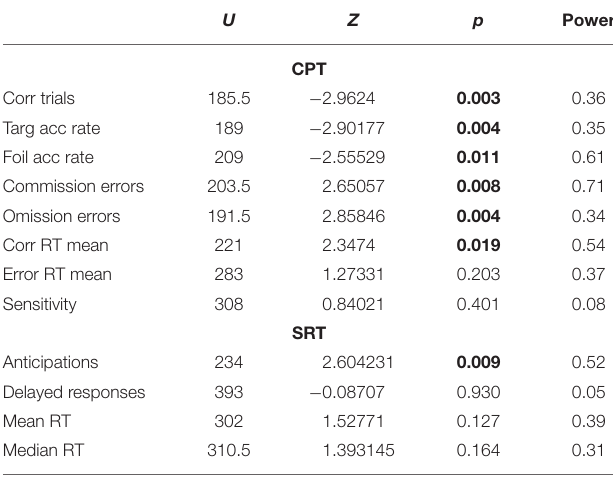
TABLE 2 | Significant differences between suicide attempters and non-suicide attempters in the Bipolar I + II group and in Bipolar I subgroup. U Z